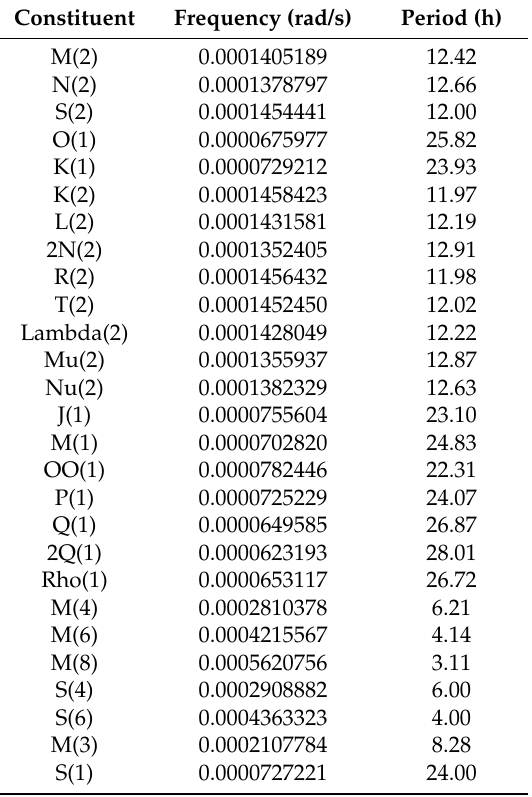
Table A2. Frequencies and periods for ENPAC15 harmonic